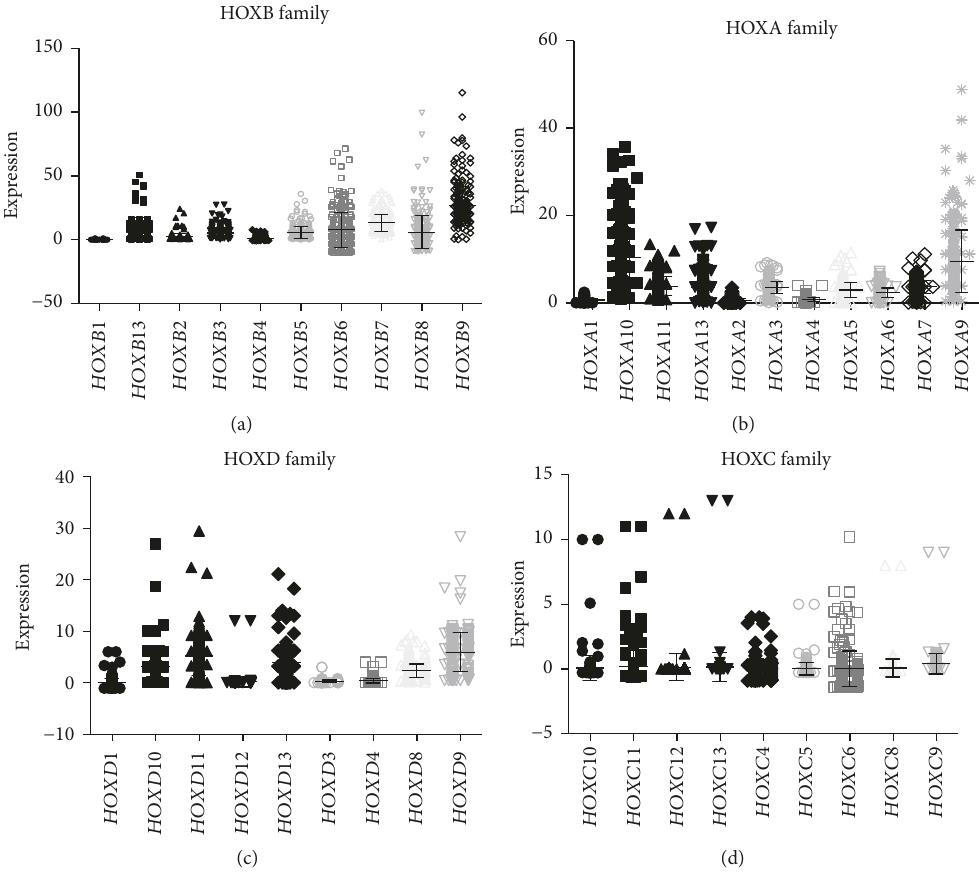
Figure 6: HOX family gene expression in CRC. (a) HOXB family gene expression, (b) HOXA family genes, (c) HOXD family genes, and (d) HOXC family genes were analyzed using TCGA RNAseq for n = 273 patient samples. y -axis denotes normalized FPKM values for HOX gene expression.